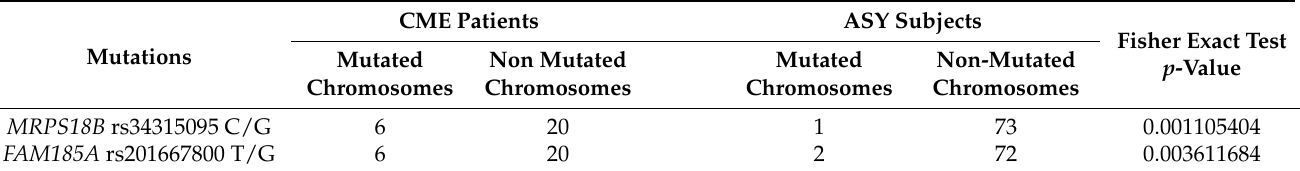
Table 3. Statistical test on mutated chromosomes.